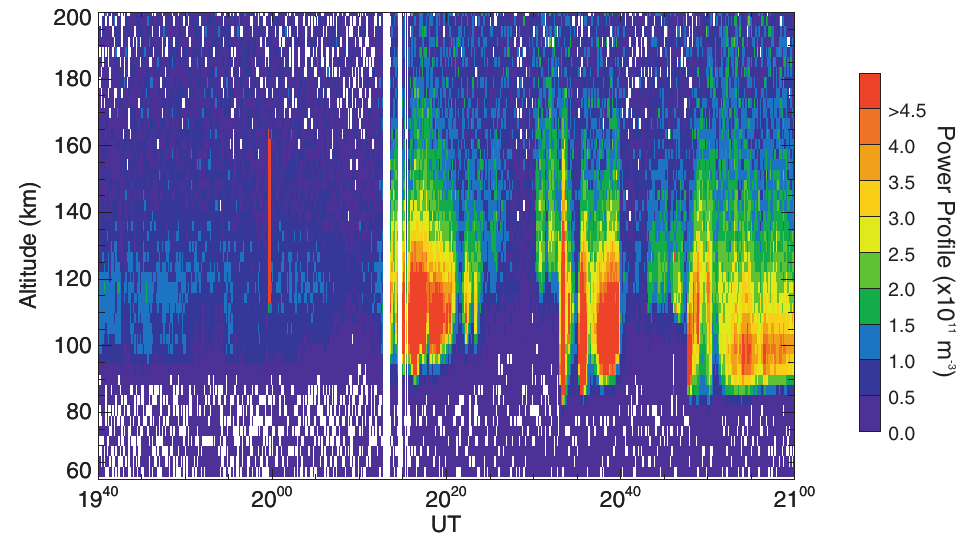
Fig. 4. Power Profile from EISCAT UHF radar for 8 October 1998, 3.1km resolution with 10s integration. Fig. 4. are indicated by coloured strips in Fig. 3. The yellow strip marks interval 1, which is from 20:16:19 to 20:16:20 UT; the pink strip marks interval 2, from 20:16:20 to 20:16:22